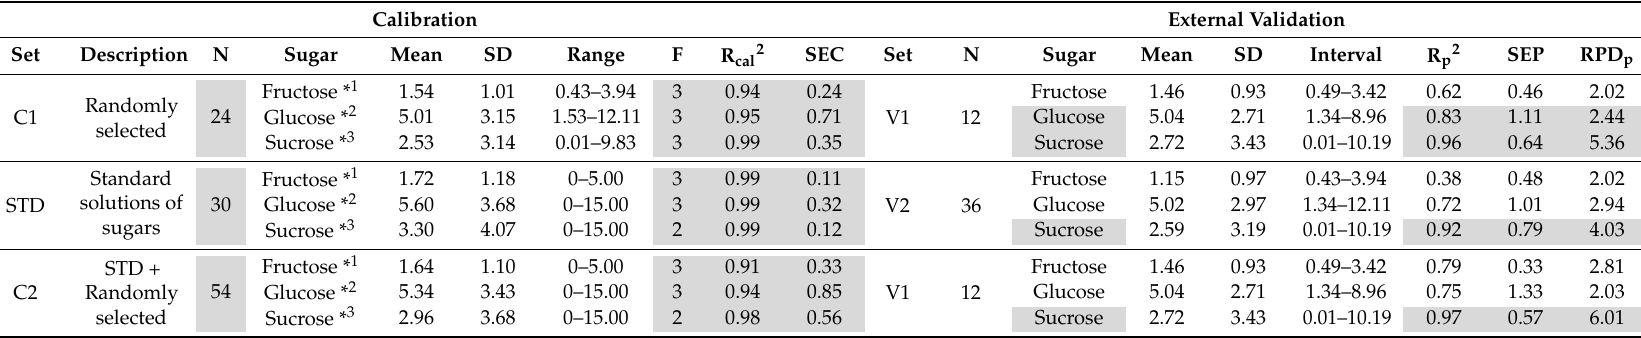
Table 4. External validation sets assessment—Descriptive statistics and performance of PLS calibration models for the prediction of sugars in the plum juice obtained from the fruit of three cultivars during their